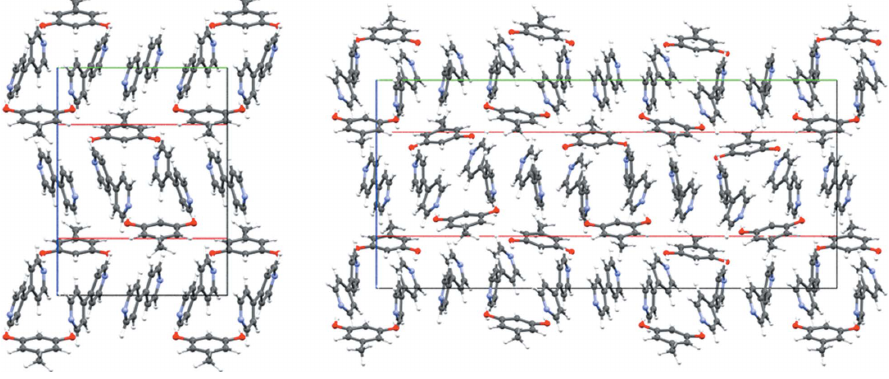
Figure 5 Orcinol–bipyridine: structure along the unique axis (shown in red) in forms III (left) and IV (right). Notice the triple modulation in the low temperature